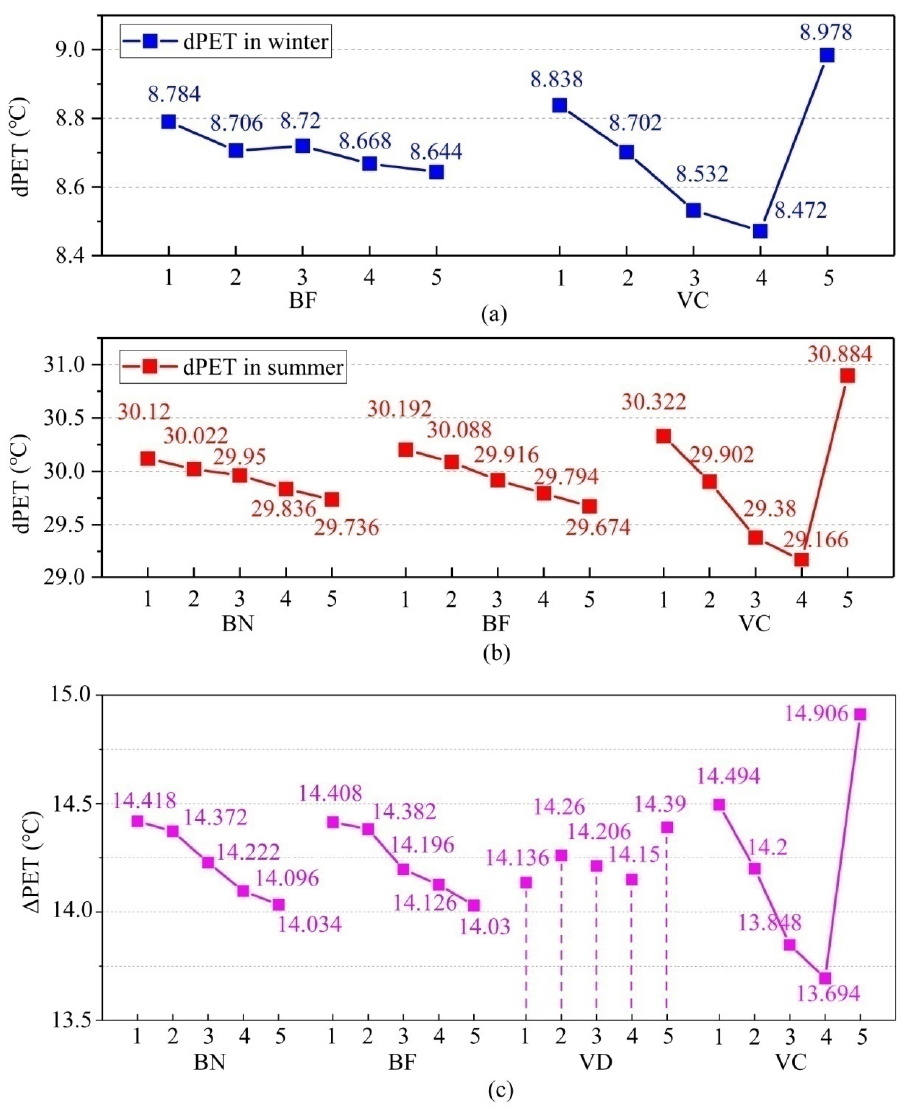
Figure 15. ( a ) Effect diagrams of significant factors on dPET in winter. ( b ) Effect diagrams of significant factors on dPET in summer. ( c ) The influence of factors and levels on Δ PET.